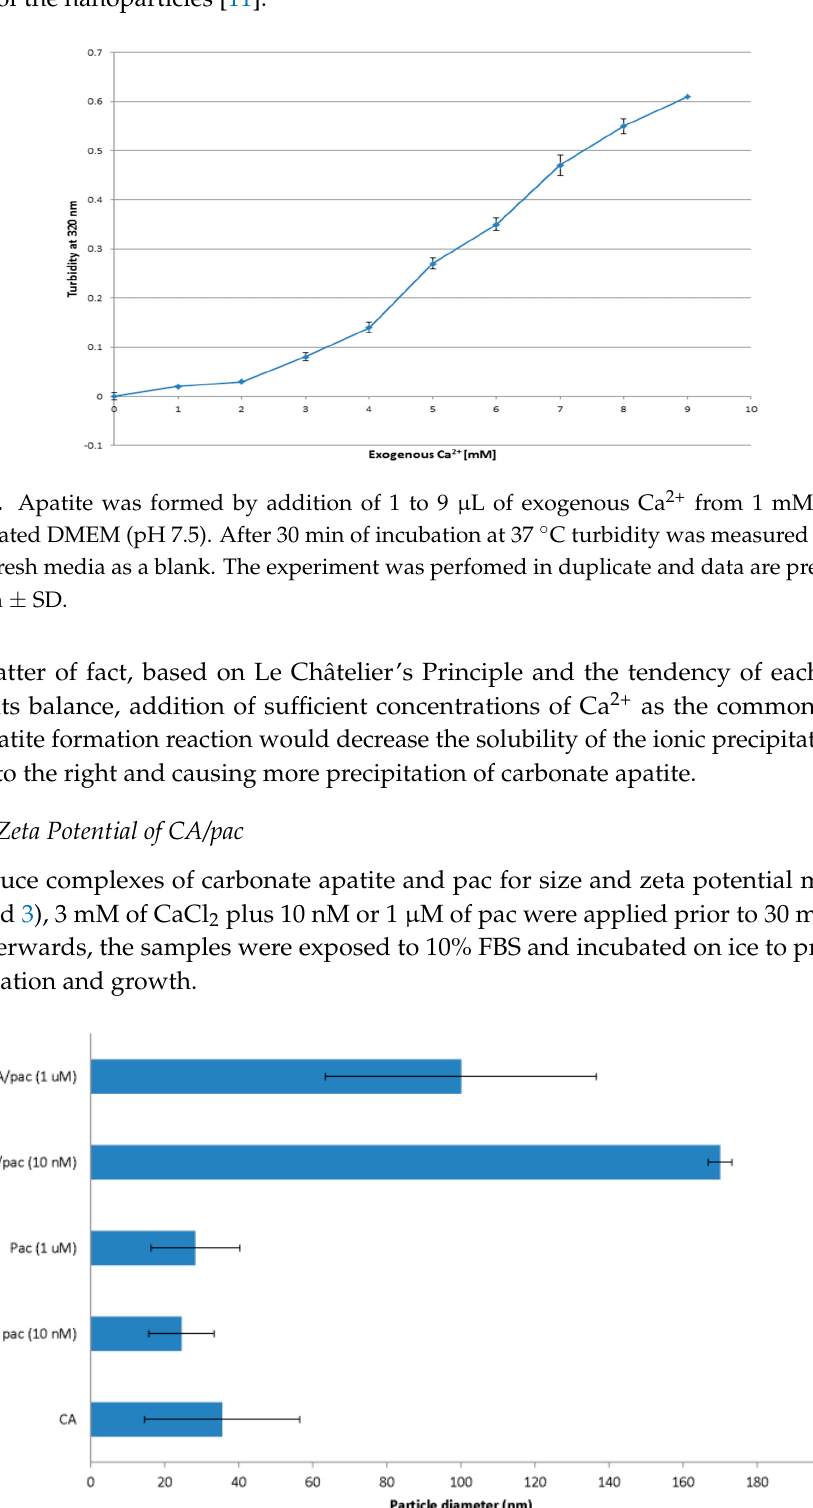
Figure 2. Size measurement for carbonate apatite particle complexes formulated by incorporation of 3 mM of CaCl 2 together with 10 nM and 1 μ M pac. The samples were then incubated at 37 °C for 30 min and also exposed to 10% FBS and maintained on ice prior to size measurement.